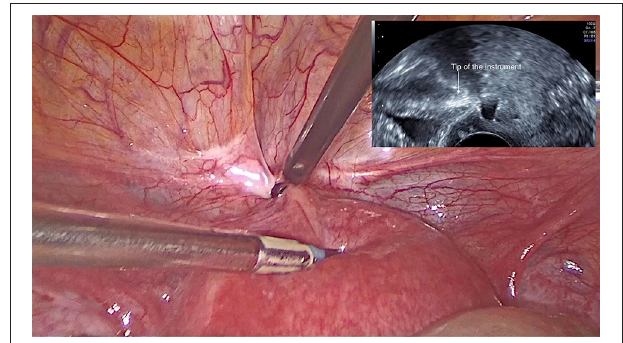
FIGURE 2 | Correct identification of the scar defect using intraoperative transvaginal ultrasound guidance.